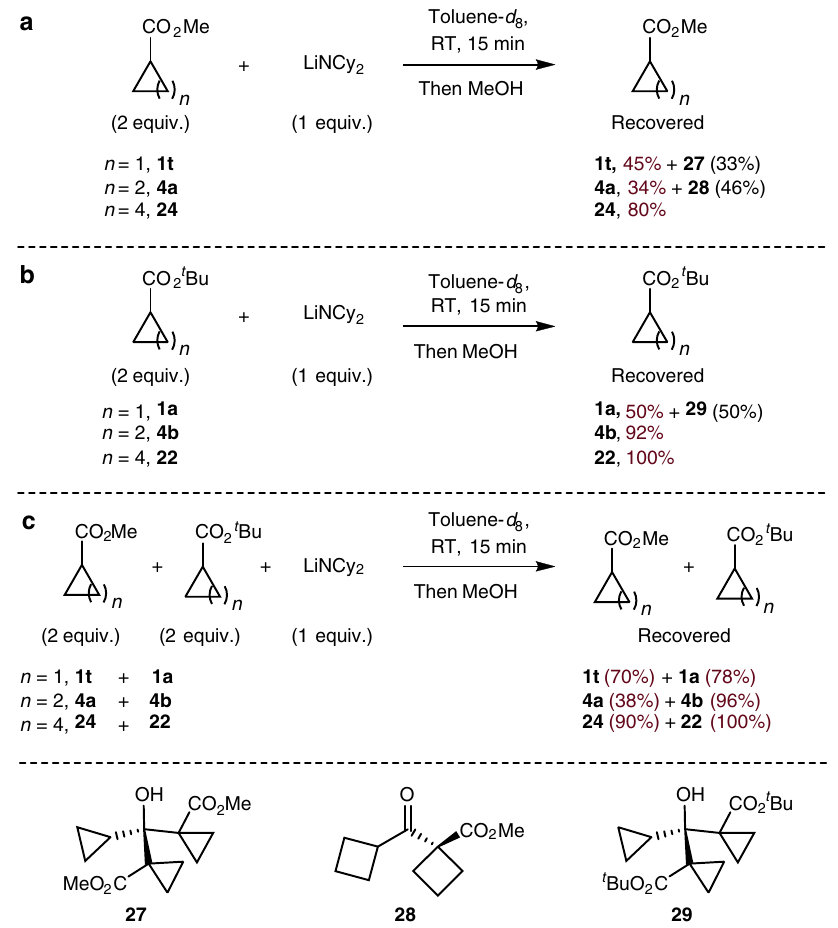
Fig. 9 Relative rates for Claisen condensation. a Claisen condensation test for cyclopropyl, cyclobutyl or cyclohexyl methyl esters individually. b Claisen condensation test for cyclopropyl, cyclobutyl or cyclohexyl t -butyl esters individually. c Claisen condensation test between methyl ester and related t - butyl ester